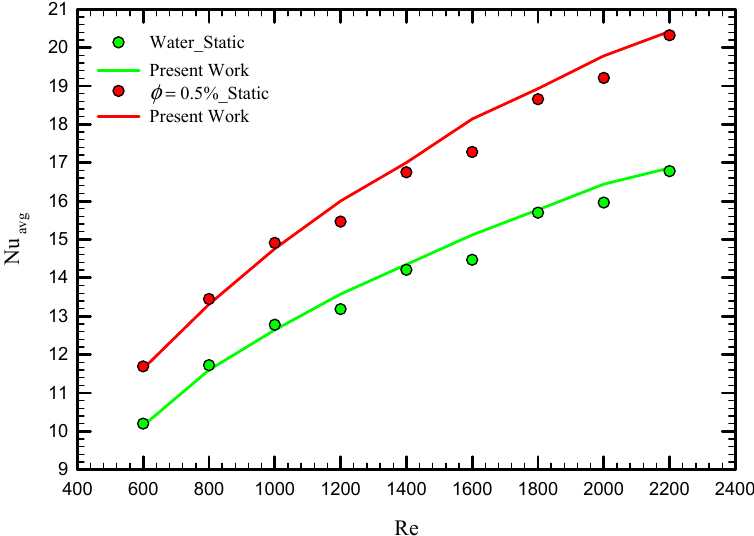
Figure 4. The validation study for the case of water and nanofluid compared with Qi et al. [52] .